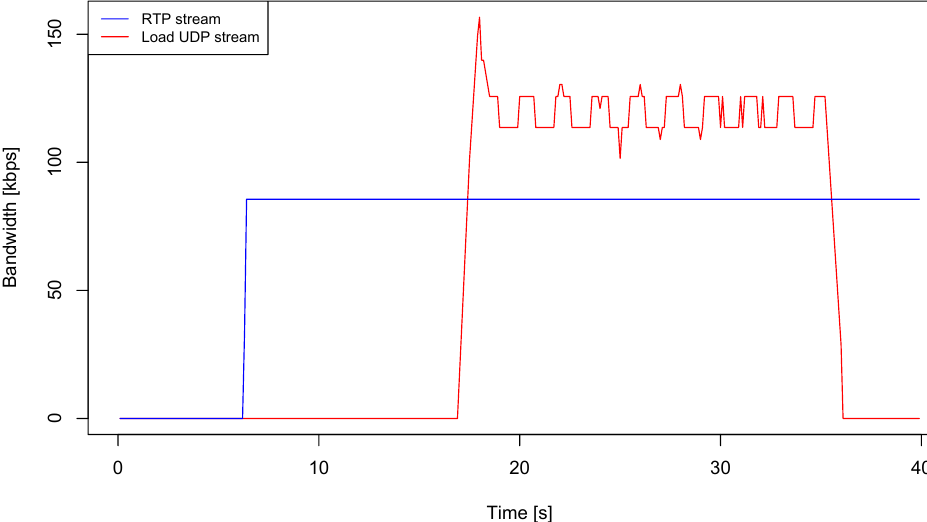
Figure 5. Bandwidth distribution with SIP proxy in the proposed